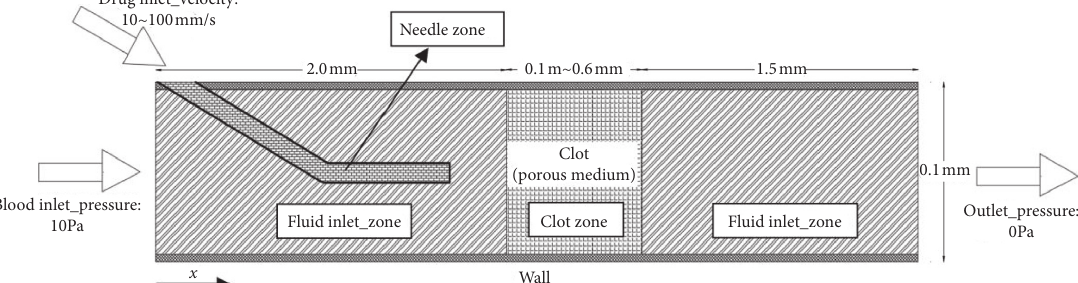
Figure 2: Thrombolytic simulation model, boundary conditions, and cell